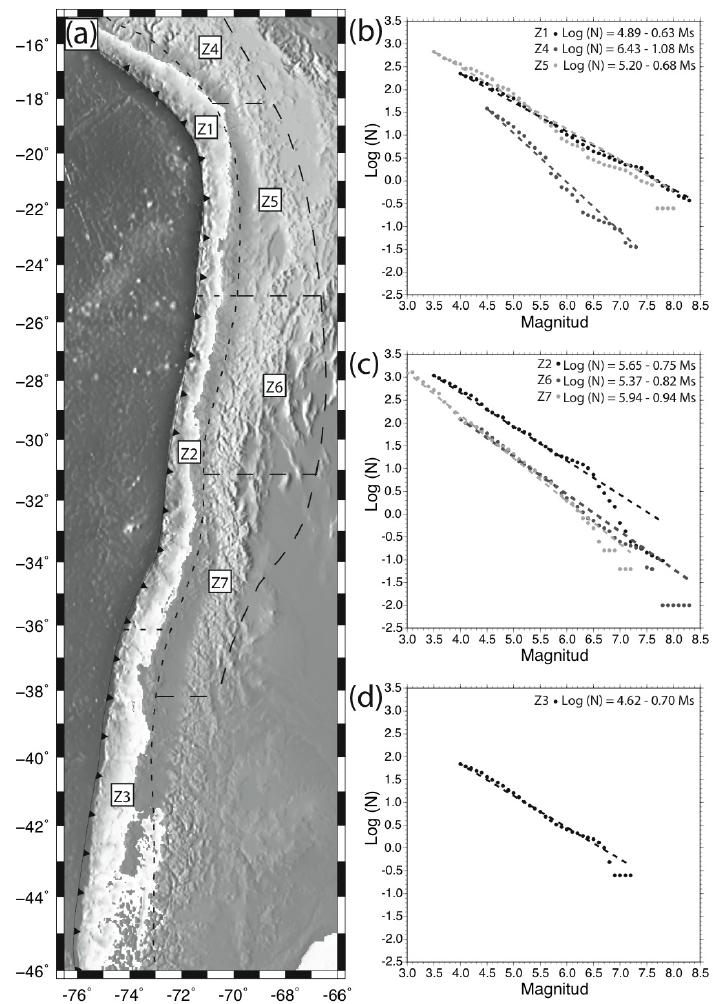
Figure S1. (a) Topographic map with location of seven zones used in this study; Z1 to Z3 correspond to interplate, thrust seismogenic sources while Z4 to Z7 are intermediate depth, intraplate seismogenic sources (modified from Martin, 1990). (b–d) Gutenberg-Richter laws for all zones considered, dashed lines represent results from maximum likelihood method (see text for details); dots represent data points for each source, according to the colour code in upper-right corner. For each subplot: (b) sources Z1, Z4, and Z5, (c) source Z2, Z6, and Z7, (d) source Z3.